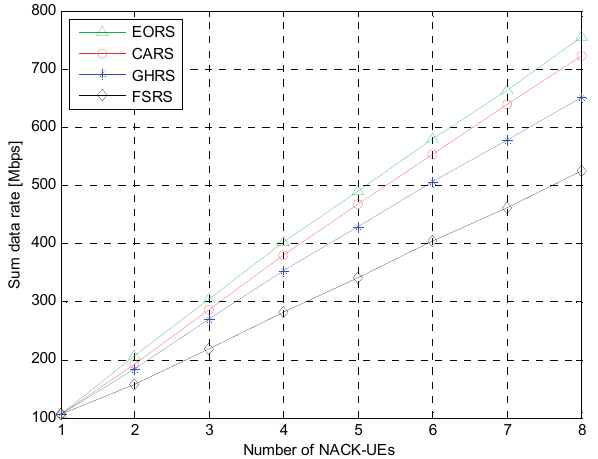
Figure 2. System sum data rate for different relay selection algorithms in the case of 4 ACK-UEs.